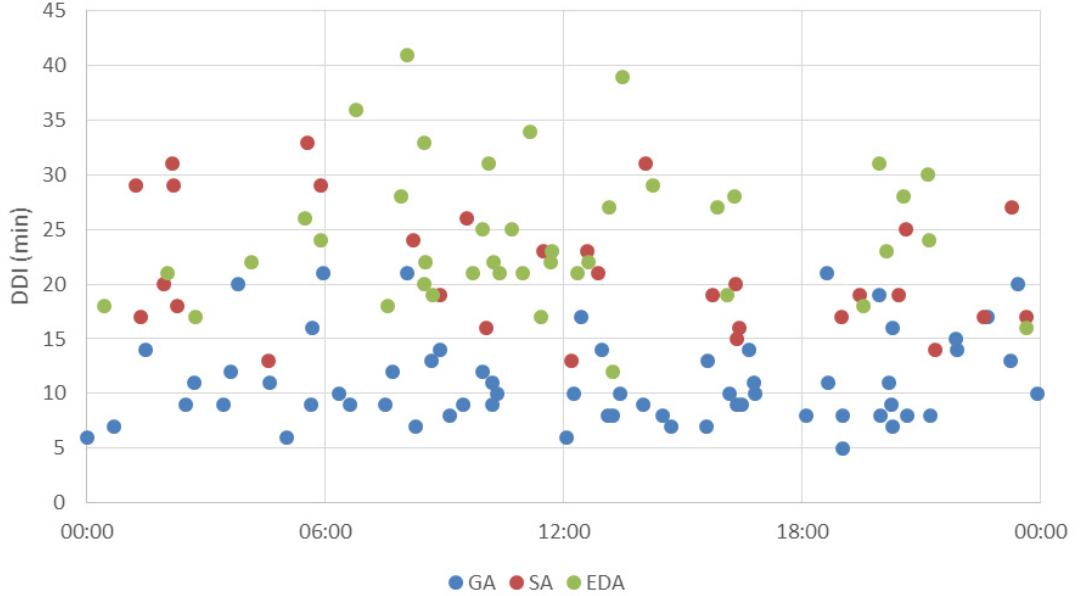
Figure 2. Decision to delivery interval for emergency caesarean sections studied (n=135) in relation to time of day. GA, general anaesthesia; SPA, spinal anaesthesia; tEDA, top-up epidural anaesthesia; DDI, decision to delivery interval.